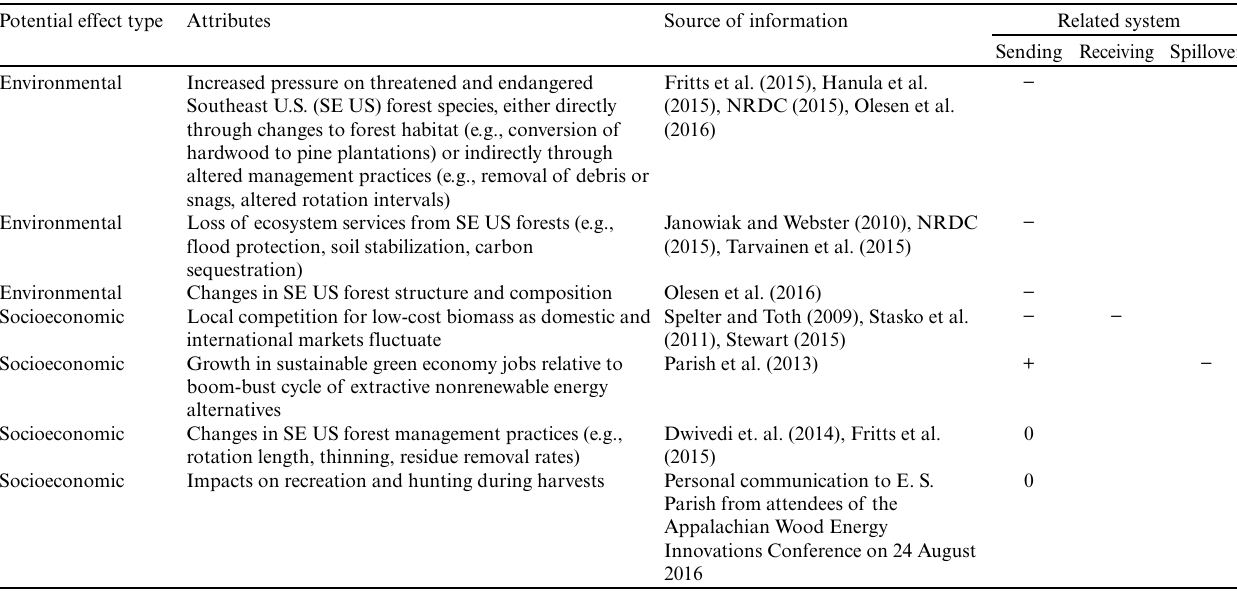
Table 6. Potential effects of the telecoupled transatlantic wood pellet trade system. Positive (+), negative (−), and uncertain (0) effects are indicated for each subsystem (Table